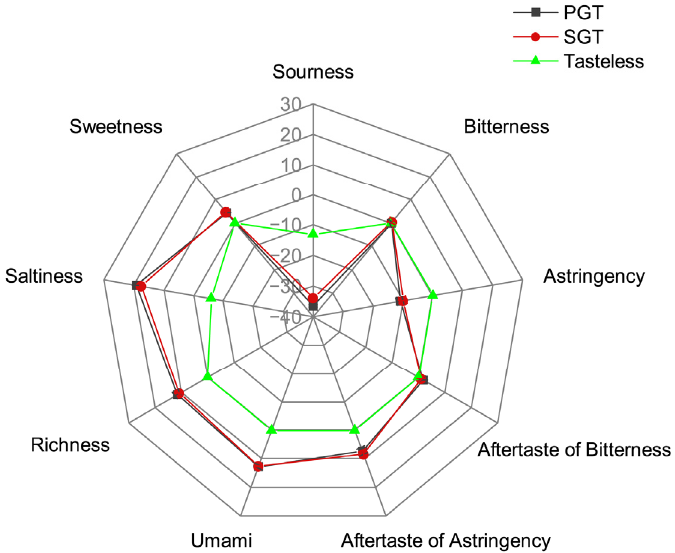
Figure 3. Effect of fixation methods on taste characteristics of green tea by electronic tongue analysis. PGT, pan-fired green tea; SGT, steamed green tea.